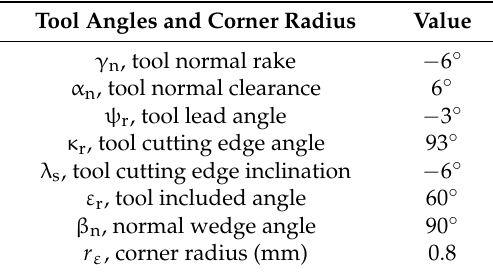
Table 2. Major cutting edge tool angles according to the tool-in-hand system, and corner radius [21]. Tool Angles and Corner Radius